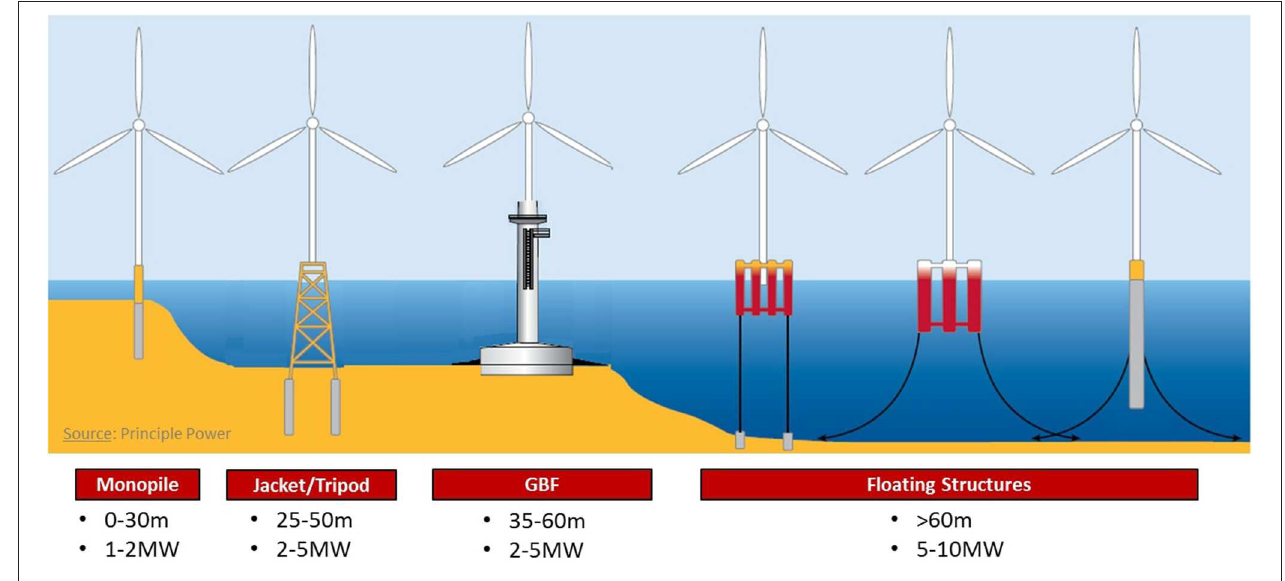
FIGURE 4 | WTG Foundation types.